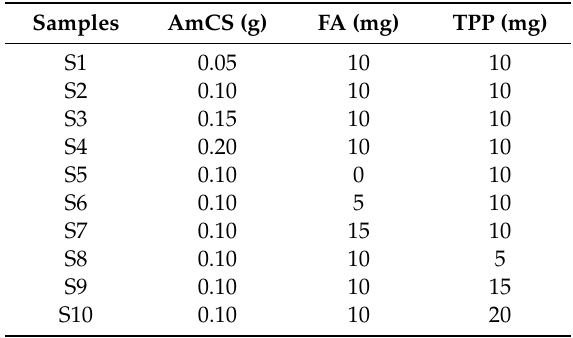
Table 1. Quantity of the reactants used in the preparation of folate-modified aminated chitosan sodium tripolyphosphate (FA-AmCS-TPP)